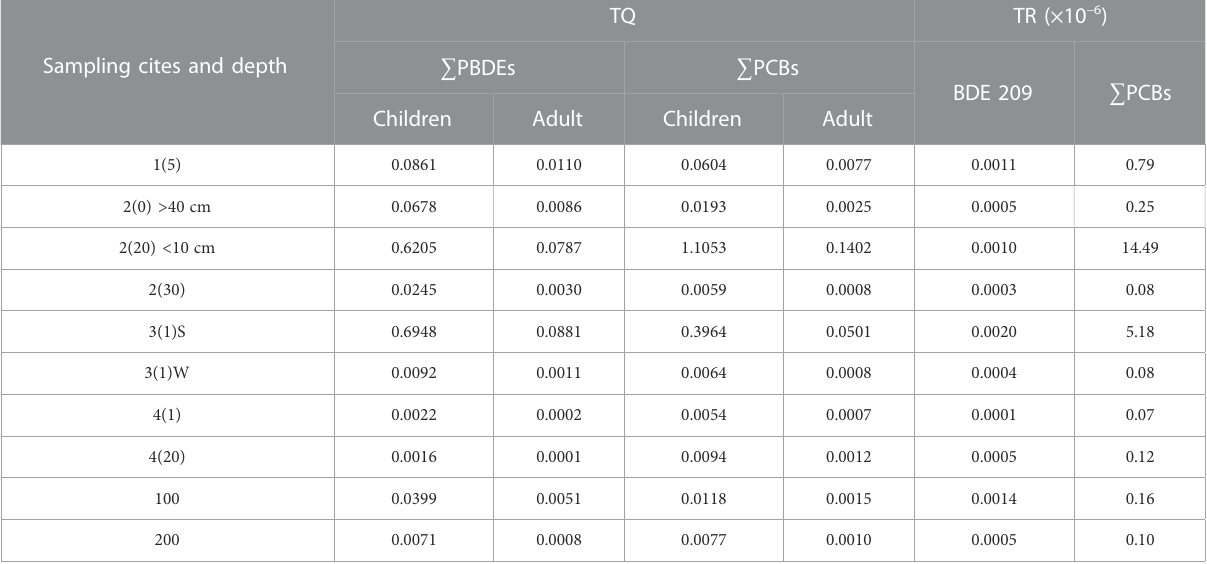
TABLE 3 Carcinogenic risks and non-carcinogenic risks of PCBs and PBDEs in soils.